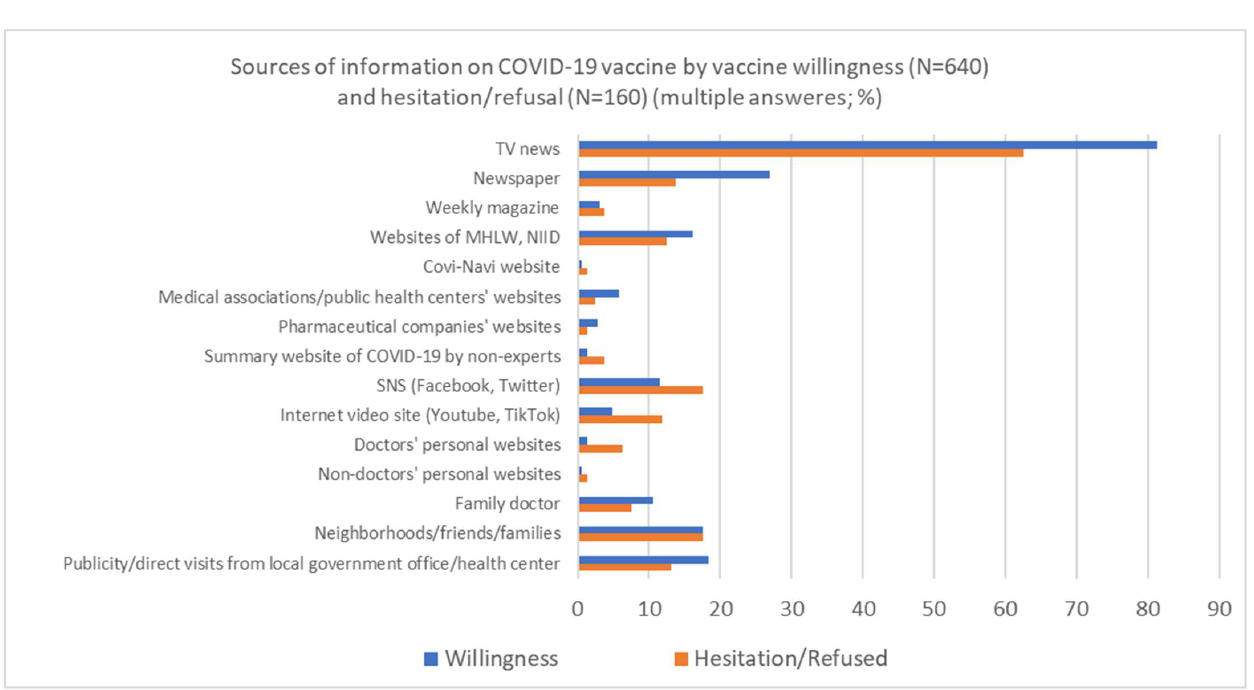
Figure 1. Sources of information on COVID-19 vaccine by vaccine willingness/hesitancy and refusal. Table 3. Adjusted odds ratio (AOR) and 95% confidence interval (CI) of logistic regression analysis for willingness to receive COVID-19